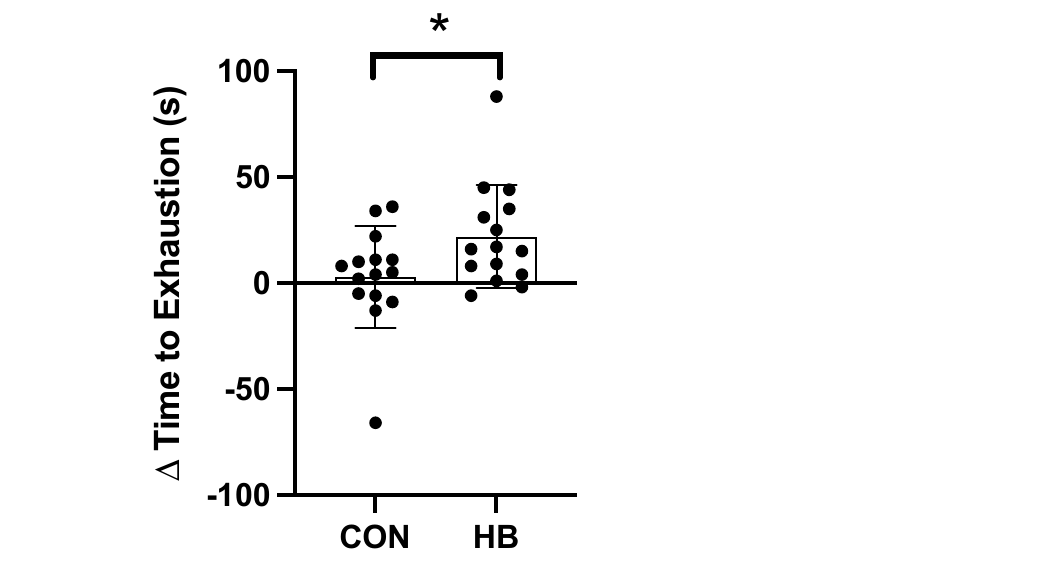
Figure 2. The change in time to exhaustion (TTE) during the V̇ ̇ O 2peak test in the placebo control (CON) and Haskap (HB) groups. Data are presented as mean ± SD; n = 30 (15 in each group); * denote significant differences between groups. Table 4. Data from the V̇̇ O 2peak test before and after the intervention of Haskap.